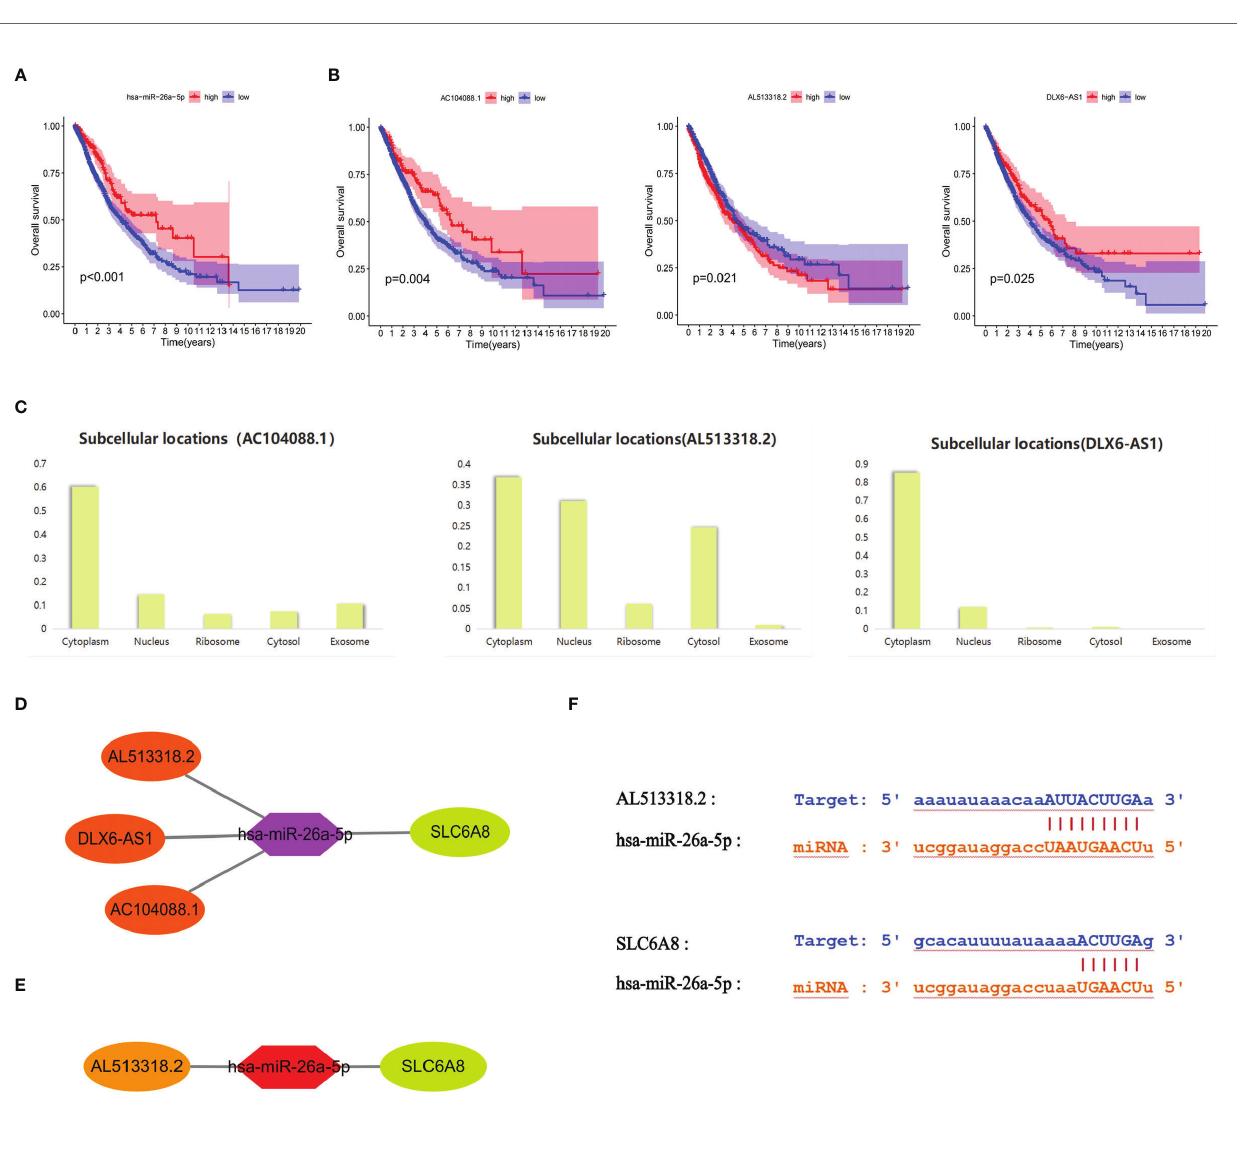
FIGURE 4 | Prognostic ceRNA regulatory network associated with SLC6A8 overexpression in NSCLC (A) Prognostic miRNAs associated with SLC6A8 overexpression in NSCLC (B) Prognostic IncRNAs associated with SLC648 overexpression in NSCLC (C) . Localization of prognostic IncRNAs in NSCLC cells (D) . The ceRNA network regulating SLC6A8 overexpression and prognosis in NSCLC (E) . The ceRNA network regulating SLC6A 8 overexpression and poor prognosis in NSCLC (F) Base pairing between Al 513318.2/hsa-miR-26a-5p and SLC6A8 /has-miR-26a-5p in Starbase online